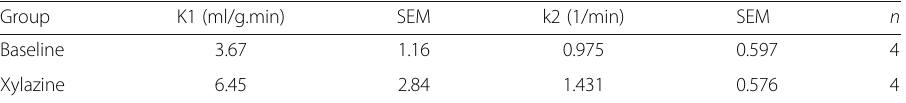
Table 1 Tracer kinetic modeling statistics prior to and post xylazine. Data are presented as mean ± SEM Group K1